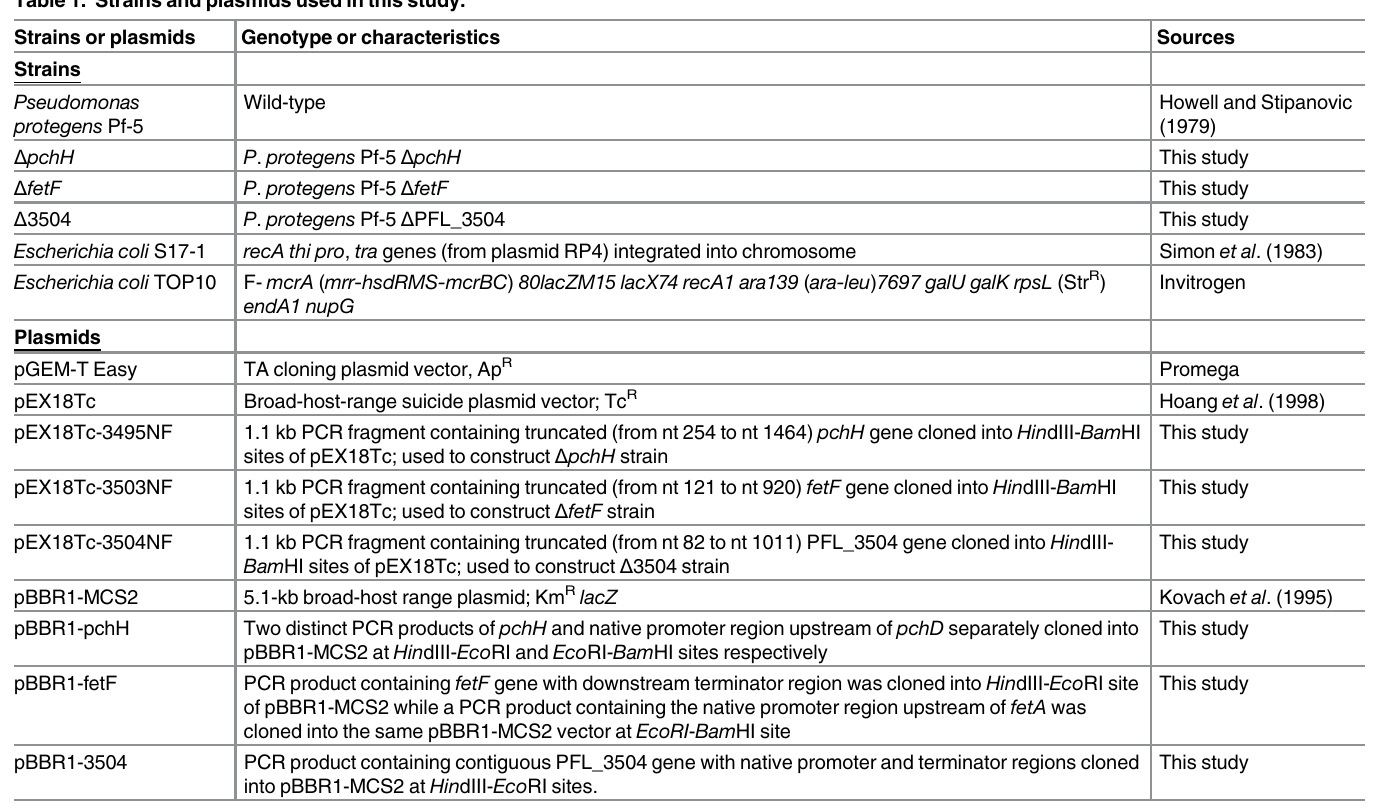
Table 1. Strains and plasmids used in this